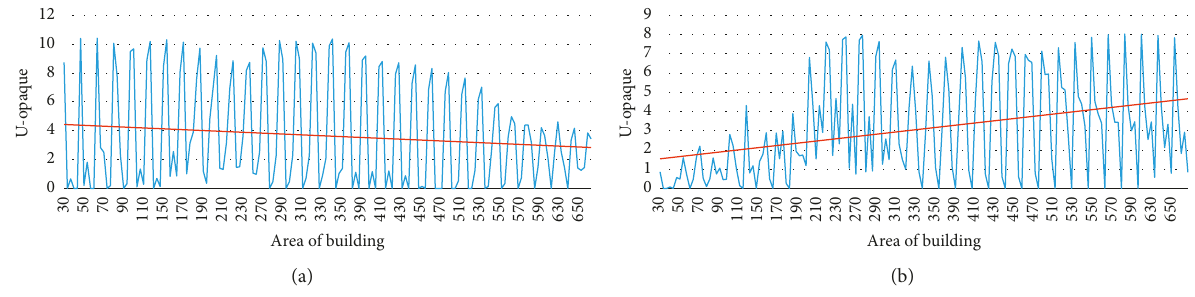
Figure 17: Sensitivity analysis results: U-opaque value versus area of the building. (a) Single-family buildings. (b) Block